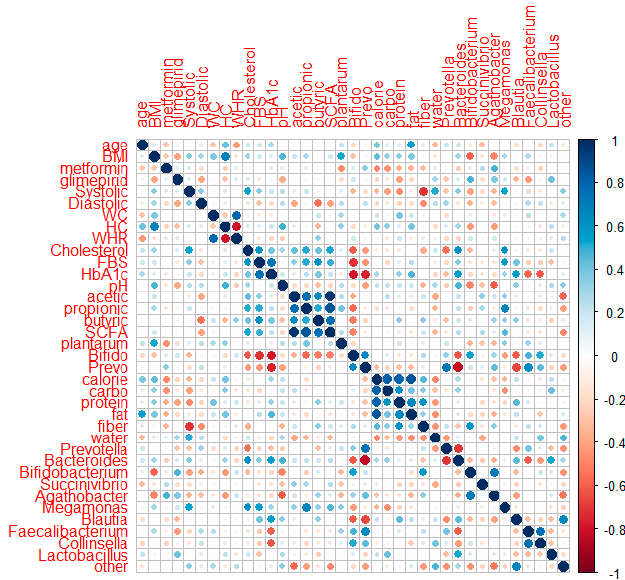
Figure 6. Corrplot of correlation between metabolic profiles, SCFA, GM at the genus level, and food intake in the placebo and probiotic groups after probiotic intervention. HbA1c had a negative association with the quantitative numbers of Bifidobacterium (r: − 0.669, p : 0.002) and Prevotella quantitative number (r: − 0.566, p : 0.014) and relative abundances of Succinivibrio (r: − 0.491, p : 0.038), Faecalibacterium (r: − 0.658, p : 0.003), and Collinsela (r: − 0.640, p : 0.004). HbA1c had a slightly positive association with body weight